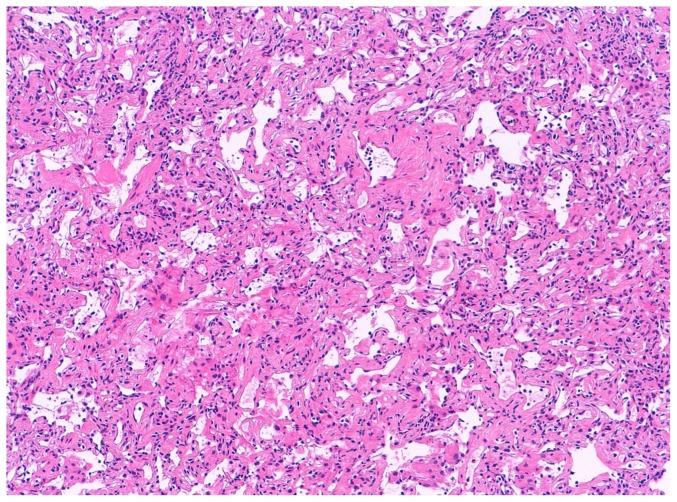
NSIP pattern.Lower lobe transbronchial cryobiopsy. A temporally homogeneous alveolar septal fibrosis is evident.